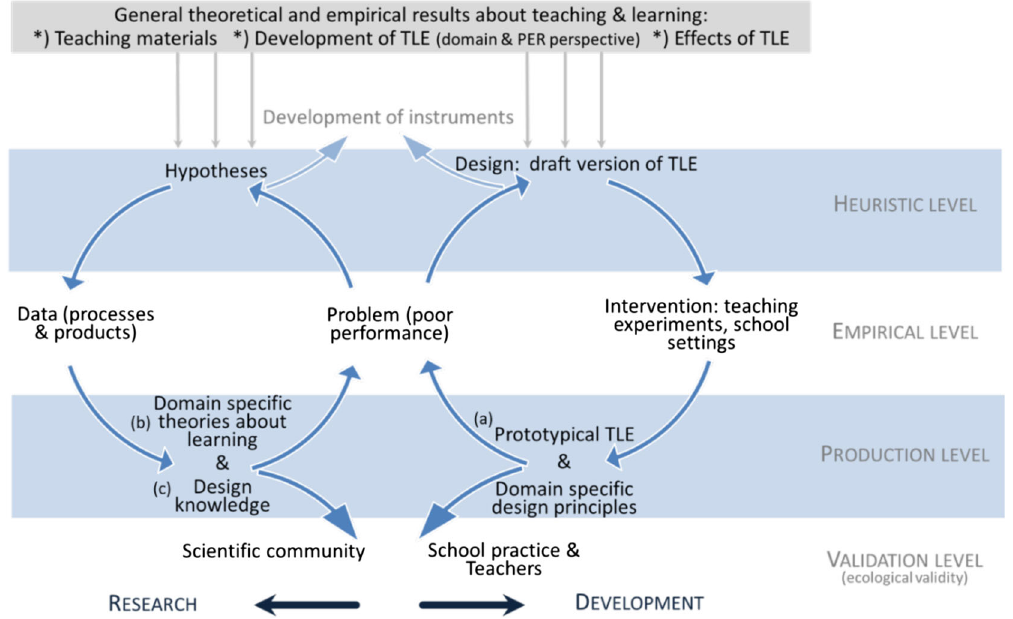
FIG. 1. Schematic model of DBR with stages in the research and development cycle. Adapted from Ref. [18]. TLE is short for teaching and learning environment. (a), (b) and (c) indicate the main objectives of our DBR project on the product